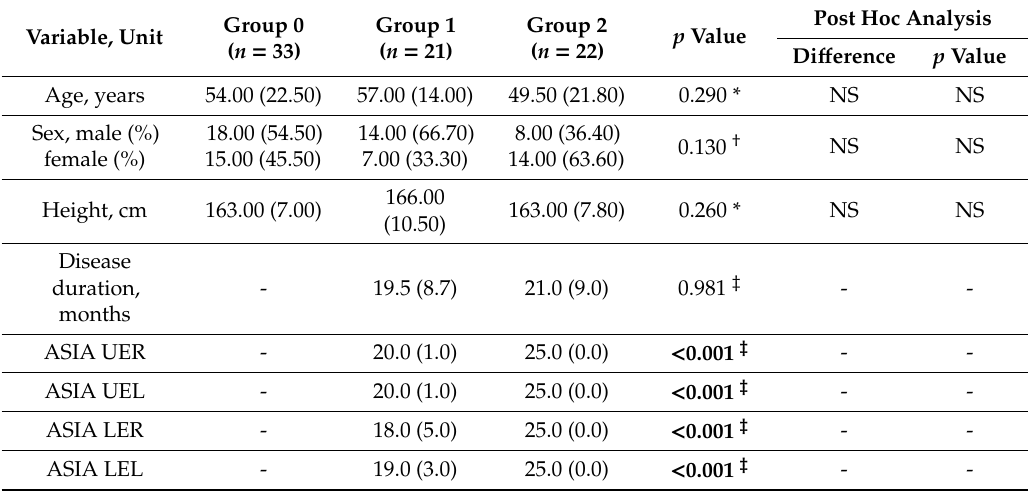
Table 1. Demographics and clinical variables of the three groups.